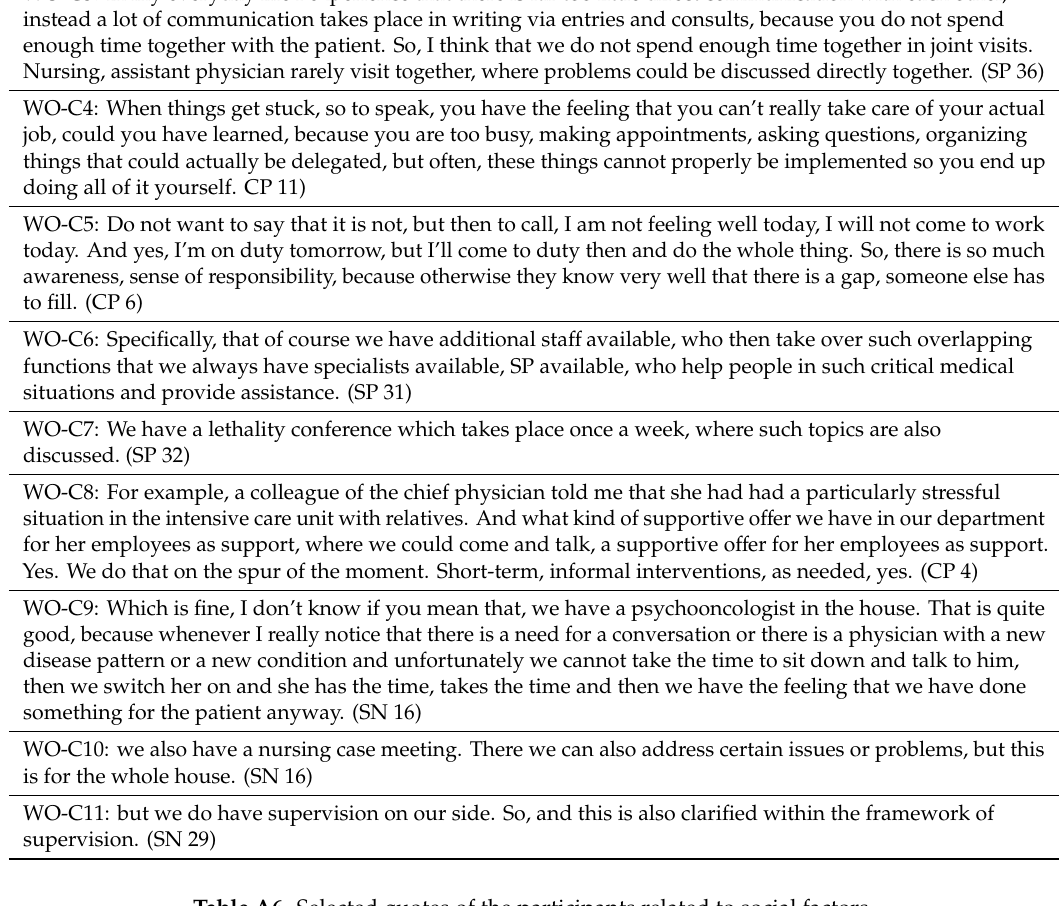
Table A6. Selected quotes of the participants related to social factors.